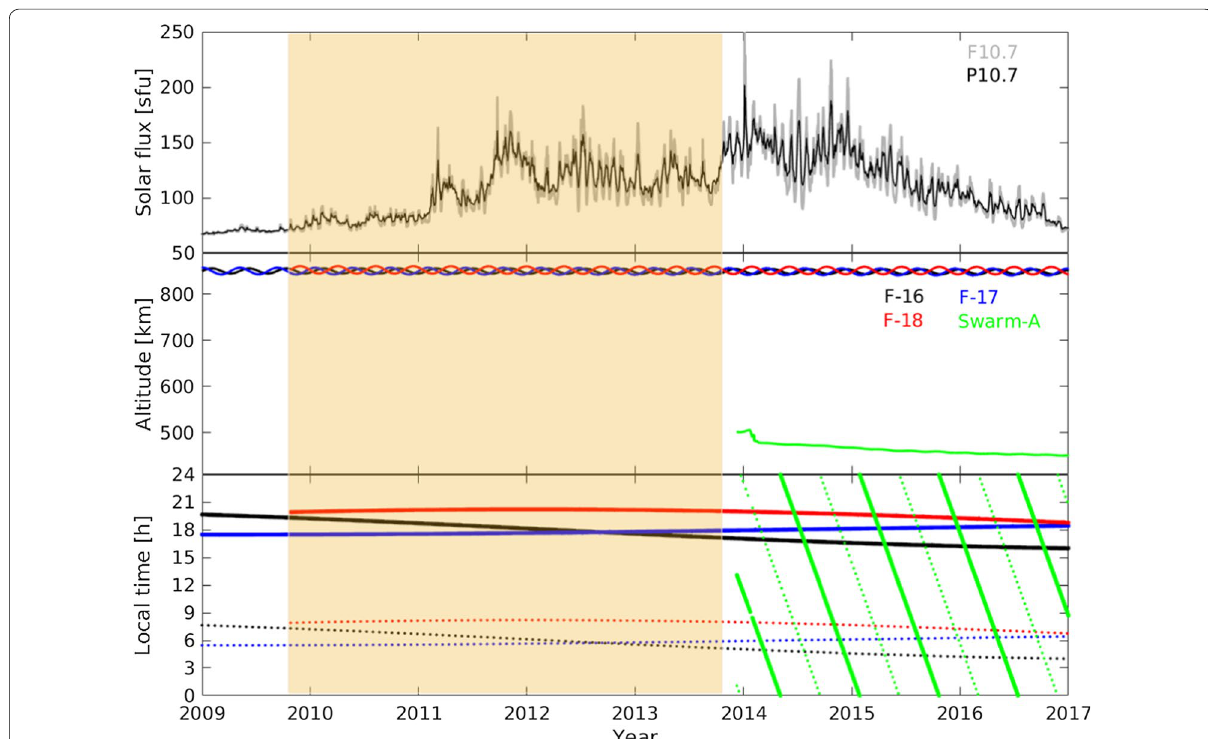
Fig. 1 (Top panel) The variation of solar flux, F10.7 (gray) and P10.7 (black), from 2009 to the end of 2016. (middle panel) The altitude evolutions of DMSP F-16 (black), F-17 (blue), F-18 (red), and Swarm A (green). (bottom panel) The local time evolutions of the four satellites, separately for ascneding (thick-solid) and descending (thin-dotted) nodes. The light-orange shaded area represents the period of available particle energy flux data from